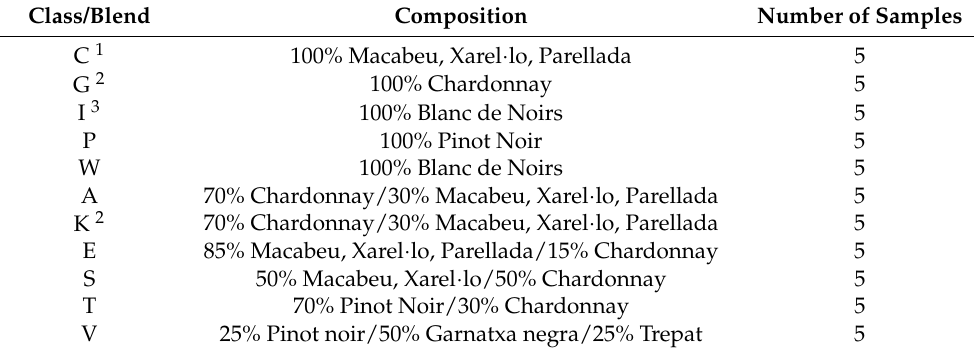
Table 2. Composition of the studied cava